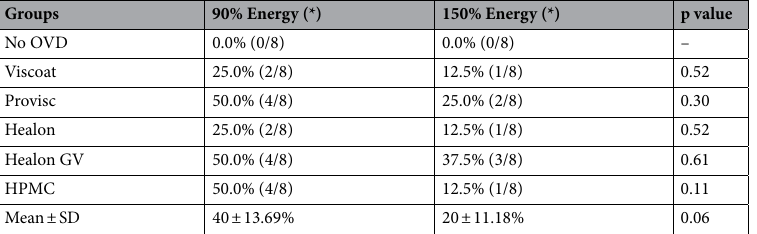
Table 2. Percentage of incomplete laser capsulotomies in different sub-groups with 90% and 150% energy settings. *The numerator represents the incomplete laser-cuts, whereas the denominator denotes the total number of samples in each sub-group.